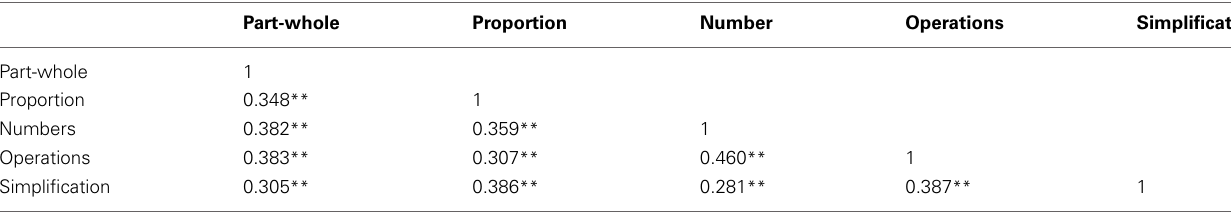
Table 2 | Correlations between conceptual items and procedural